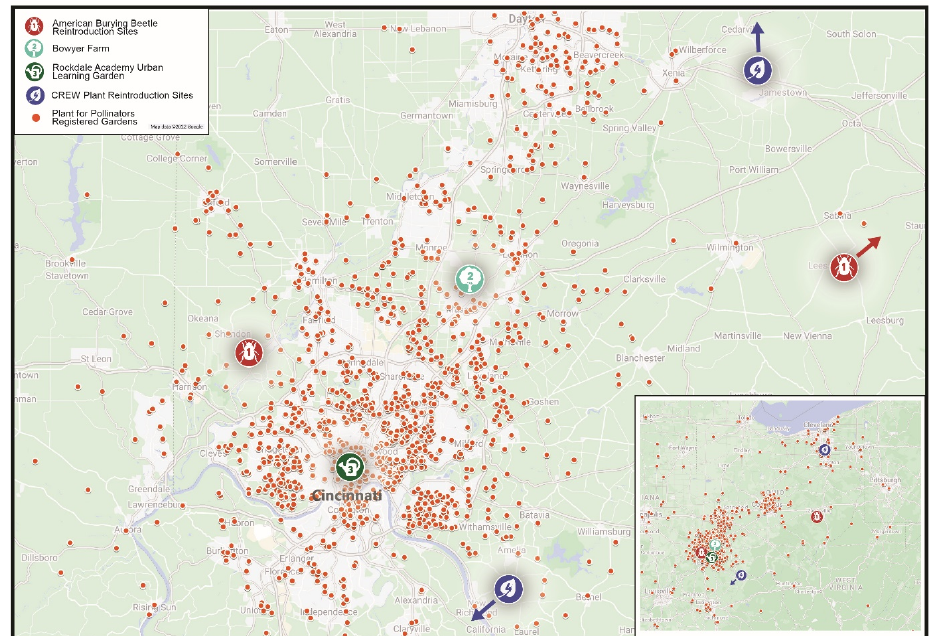
Figure 1. A map depicting the approximate location of the five CZBG local conservation case studies across Ohio, as well as parts of Kentucky and Indiana. These widespread programs create an abundance of vibrant landscapes by mobilizing community members in CS, allowing for greater outcomes from staff engagement. Program icons are defined in the top left key. The bottom-right square depicts the zoomed-out scope of projects across Ohio and the surrounding states. The reintroduction sites for (1) ABB and (4) CREW are approximately marked with an arrow to indicate direction without identifying specific locations of the highly sensitive, endangered species.